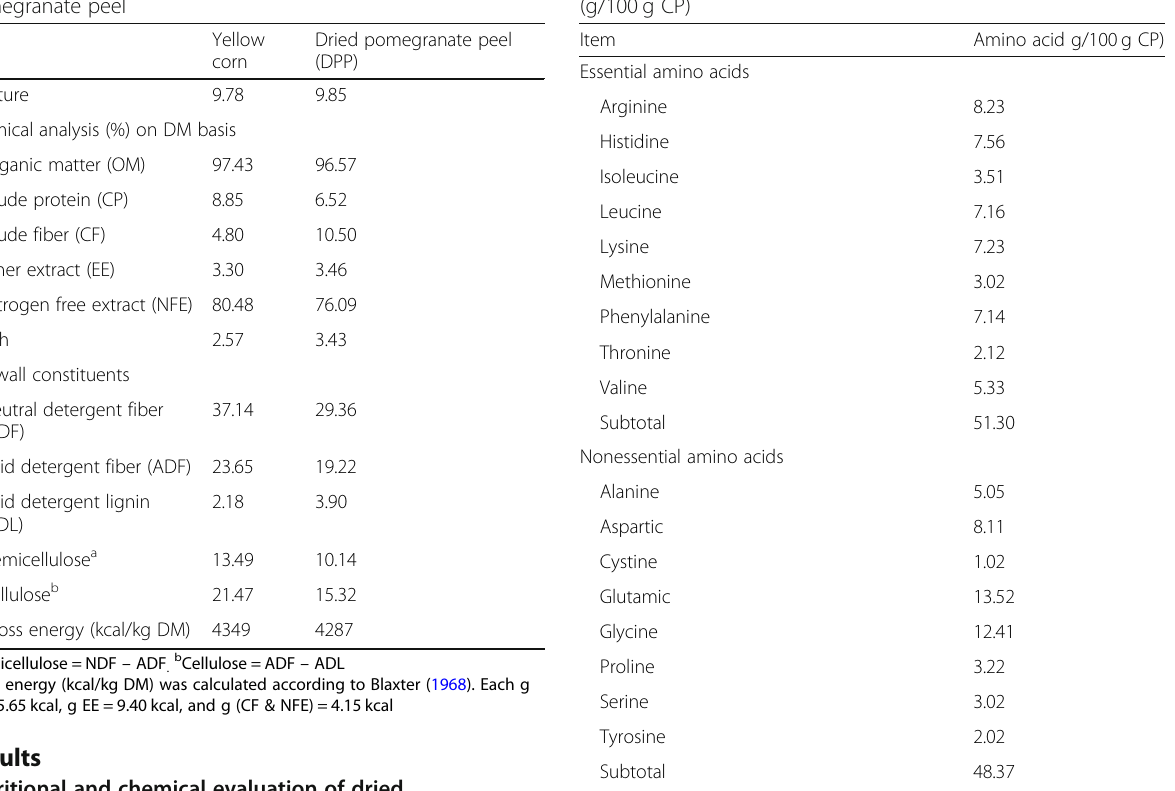
Table 2 Amino acid composition of dried pomegranate